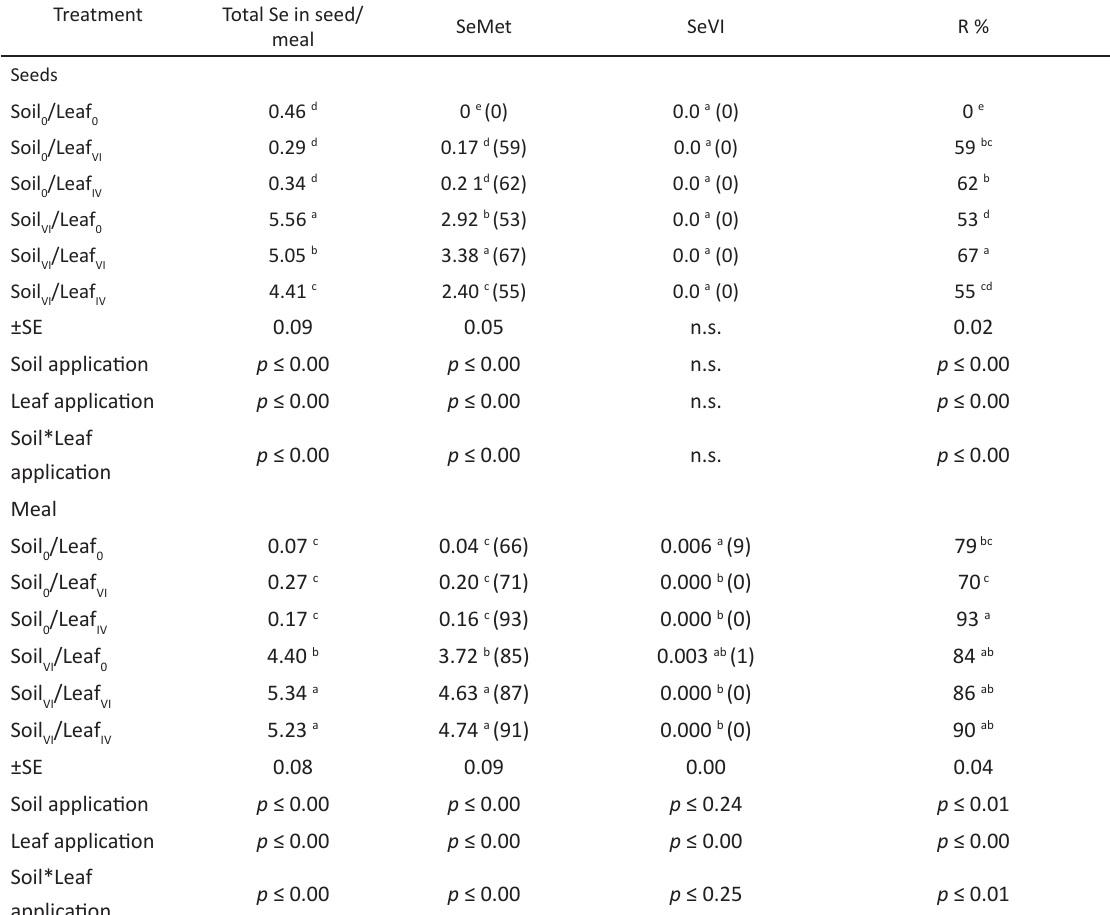
Table 2. The concentrations of total Se and different Se species (µg g -1 DM) in Brassica napus seeds and meal in mature plants after treatment with 0 or 130 µg Se plant -1 as Na or Na SeO , (Leaf0, LeafVI and LeafIV respectively). Selenomethionine (SeMet) and inorganic SeVI were detected. The recovery 2 3 (R %) was calculated by ratio of the sum of Se species to the total Se obtained by the acid digestion method. The number inside brackets is the percentage of different Se species from total